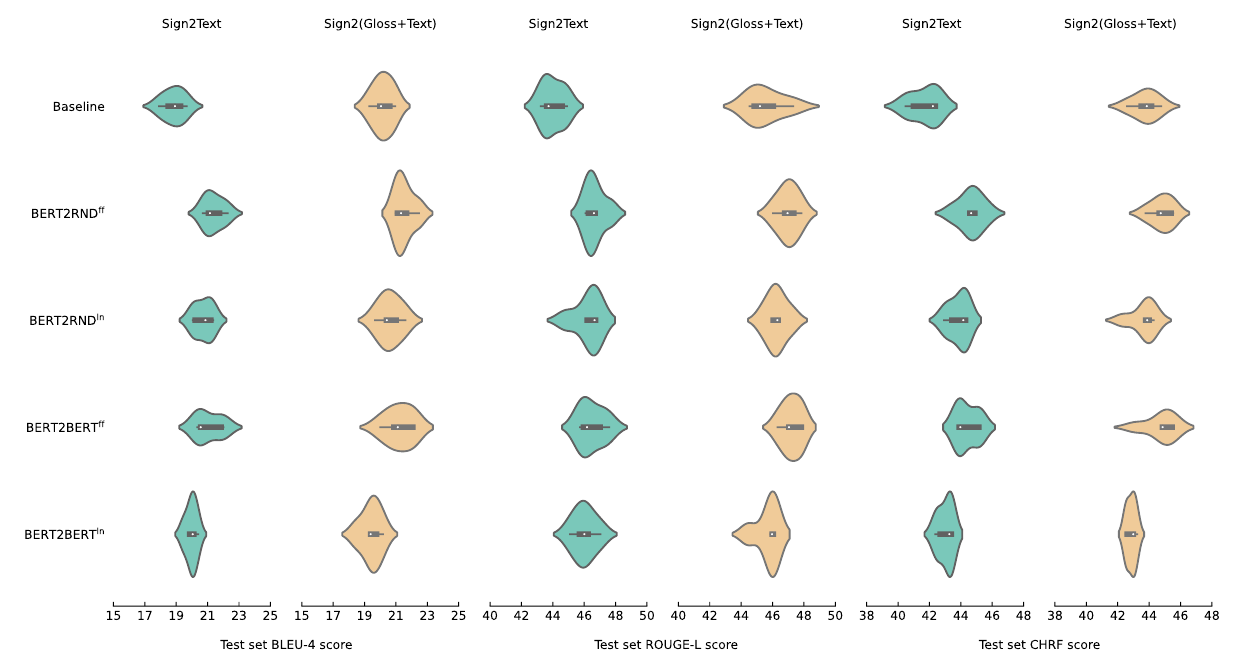
Figure 3. The FPT models outperform the Baseline model for the Sign2Text task. For the Sign2(Gloss+Text) task, the difference is less pronounced.